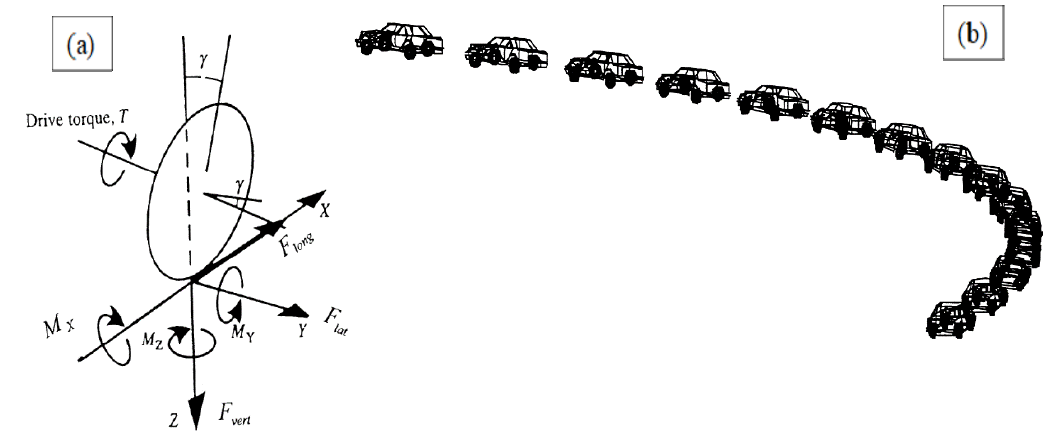
Figure 4. ( a ) Forces acting on vehicle tires due to engine torque, ( b ) simulated vehicle maneuver for 5s [18].